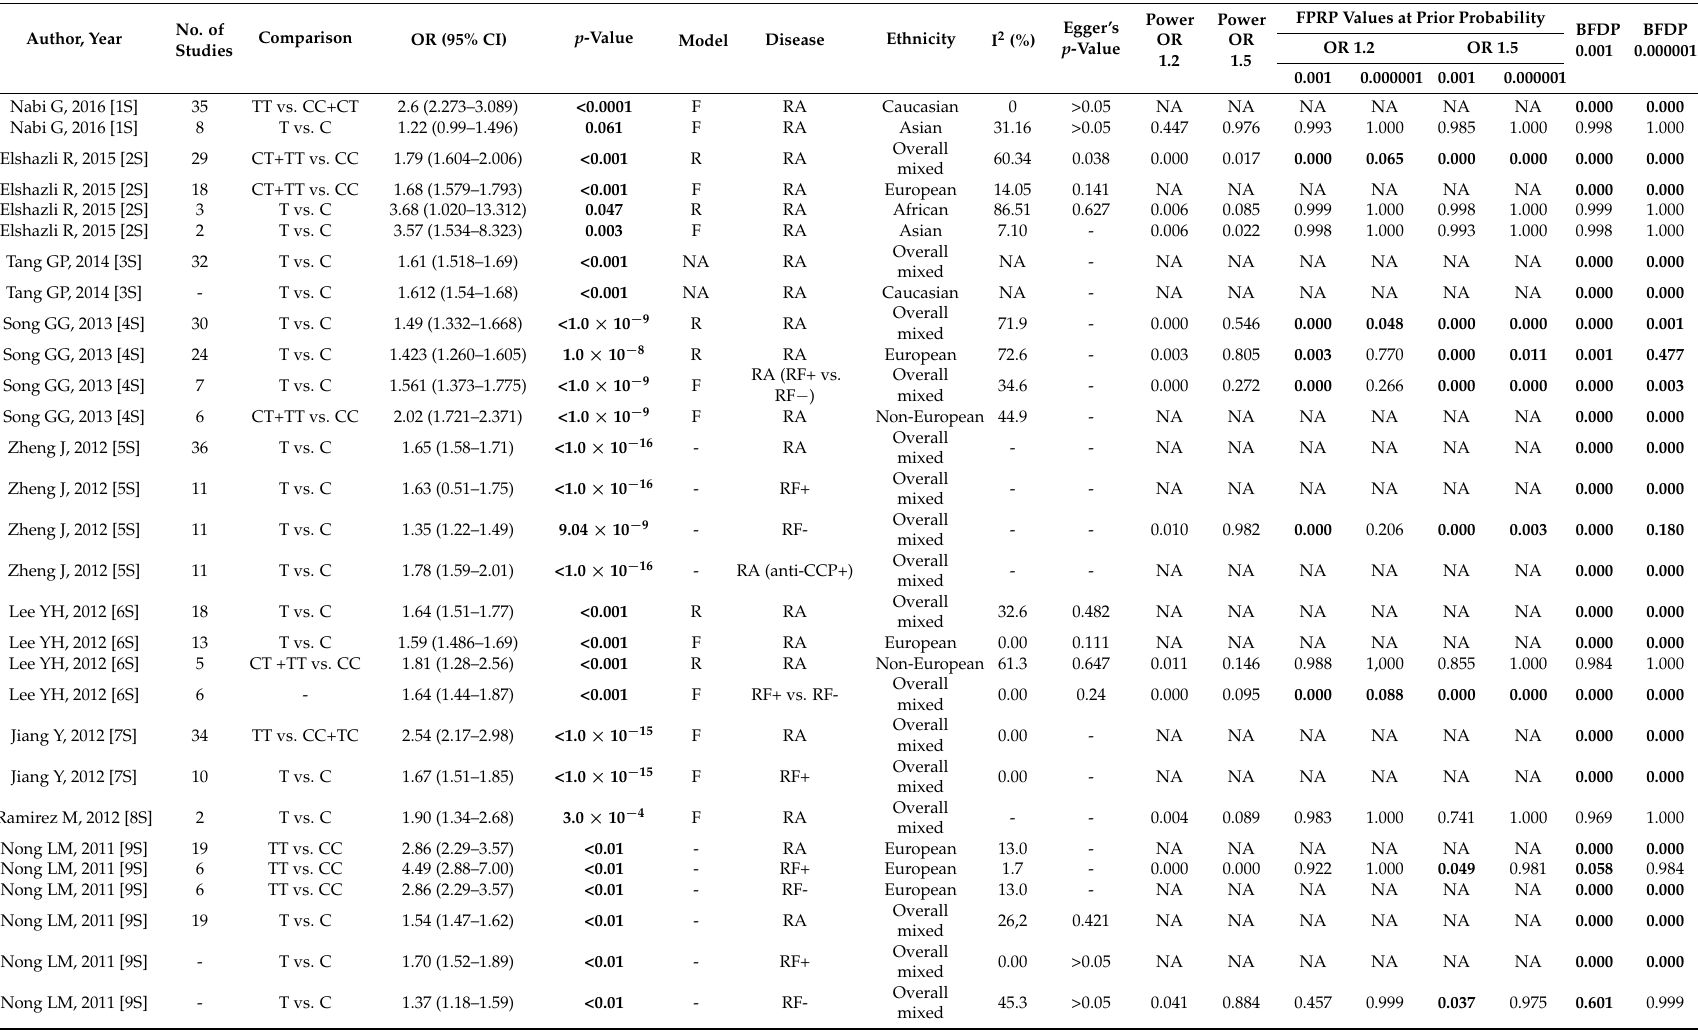
Table 1. Meta-analysis results of associations between rheumatoid arthritis (RA) and the PTPN22 1858 C/T polymorphism from observational